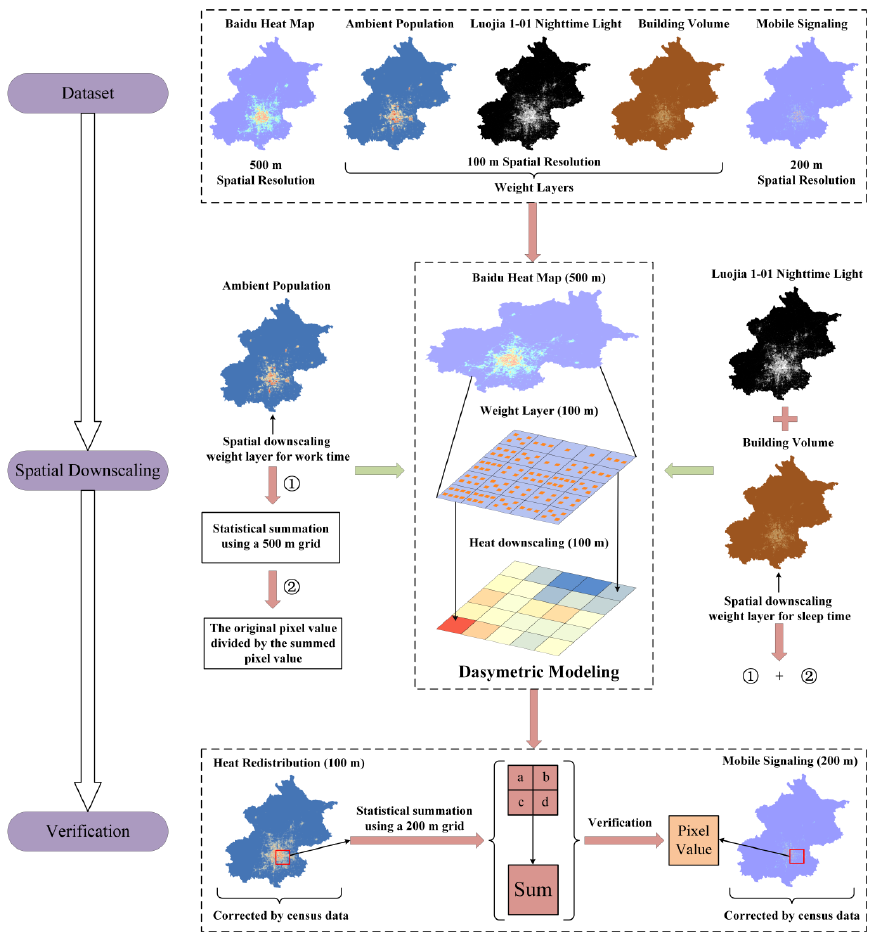
Figure 3. A spatial downscaling framework for Baidu heat map during work time and sleep